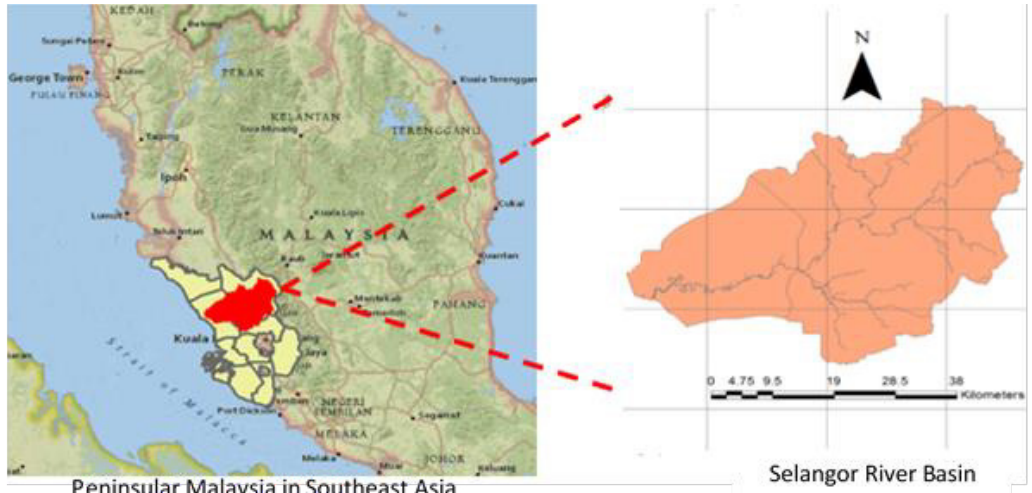
Fig. 1: Geographic location of the study area in the State of Selangor in Malaysia, Southeast